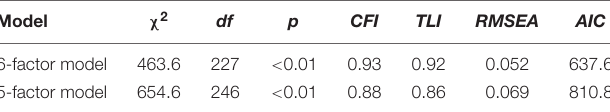
TABLE 3 | Model fits of the 5-factor and 6-factor models (Study